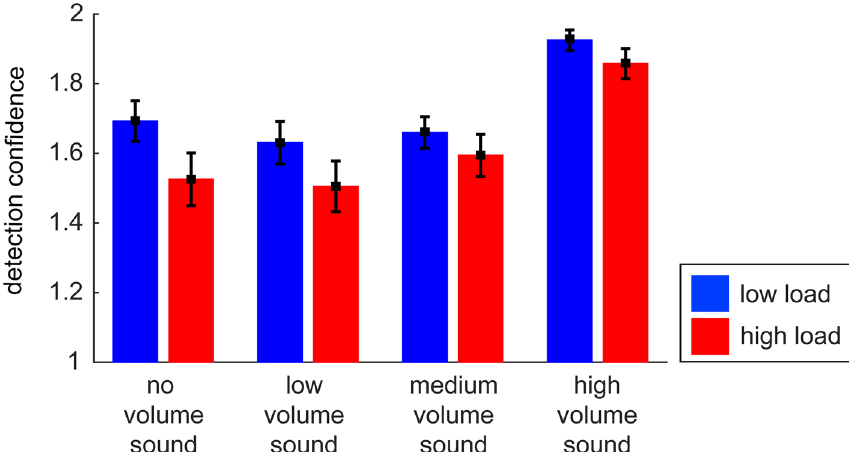
Figure 5. Detection confidence of the sound perception for the no, low, medium, and high volume sound in the two load